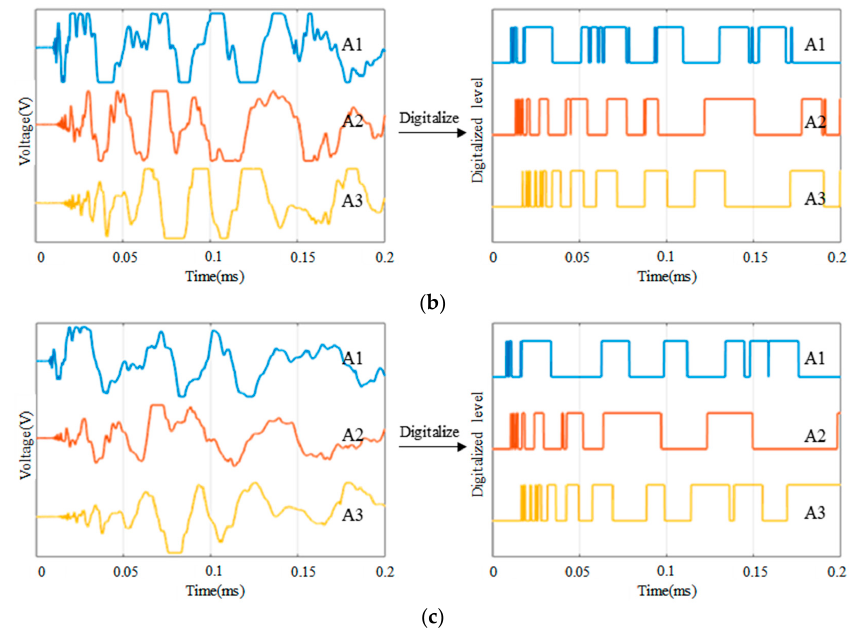
Figure 10. Typical impact response signals and CDSs of different sensor connection types under impact energy level 3: ( a ) The impact response signals and CDSs of PZT 3 , PZT 6 and PZT 9 in independent connection type; ( b ) The impact response signals and CDSs of A1, A2 and A3 in series connection type; ( c ) The impact response signals and CDSs of A1, A2 and A3 in parallel connection type.